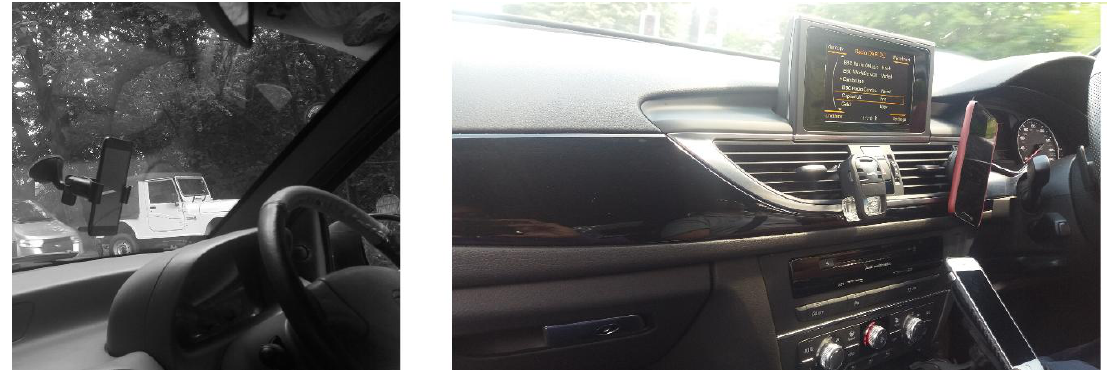
Figure 38. Existing car dashboard in line of sight of drivers.